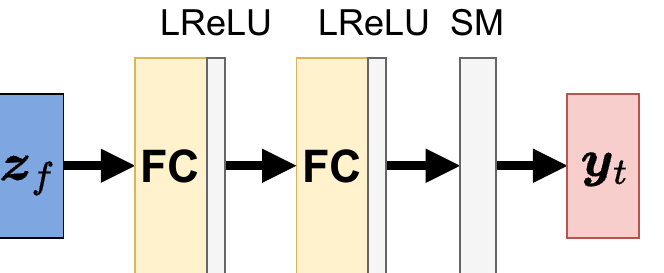
Figure 4. Overview of the auxiliary adversarial classifier C adv . The classifier consists of MLP with two fully connected (FC) layers and leaky ReLU (LReLU) and a softmax (SM) layer. The output is the predicted distribution y t of class labels for dynamic